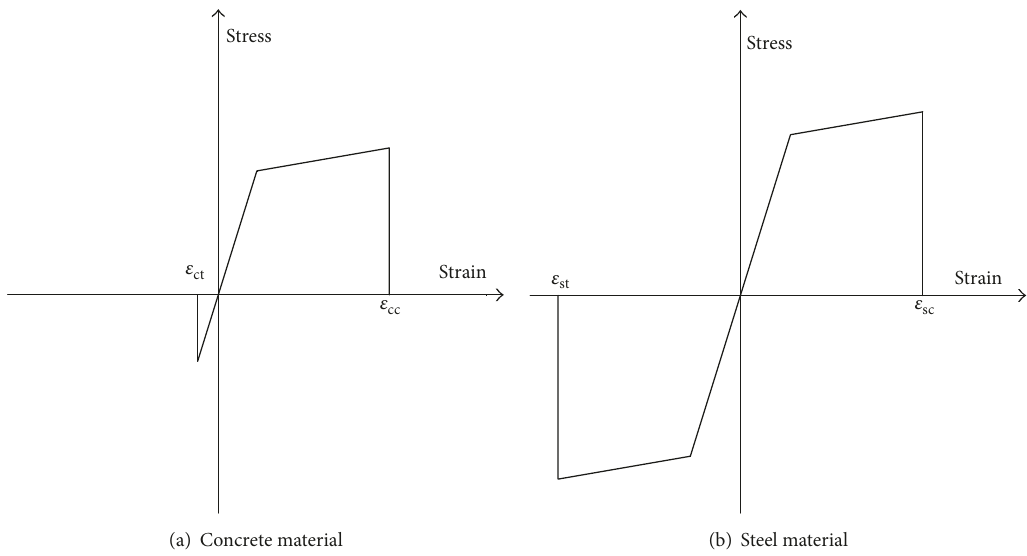
Figure 2: Material failure models of concrete and